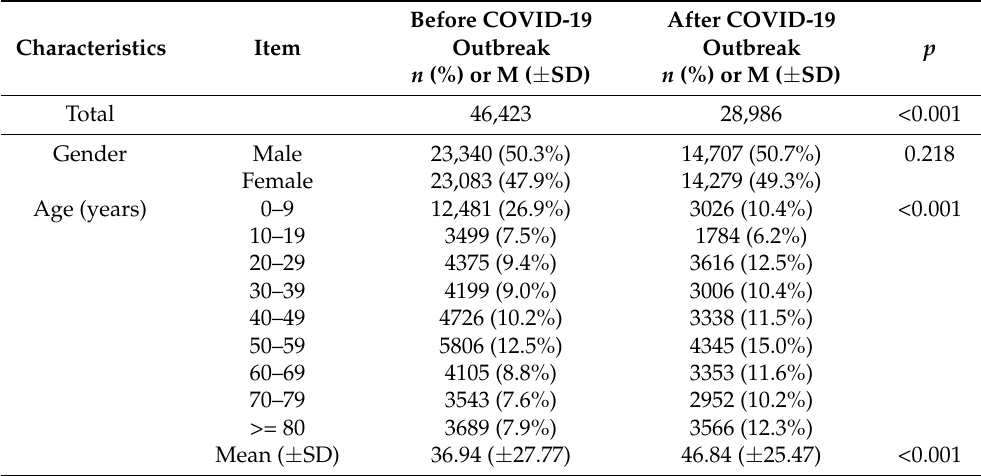
Table 1. General characteristics of emergency room patients before and after the COVID-19 outbreak.